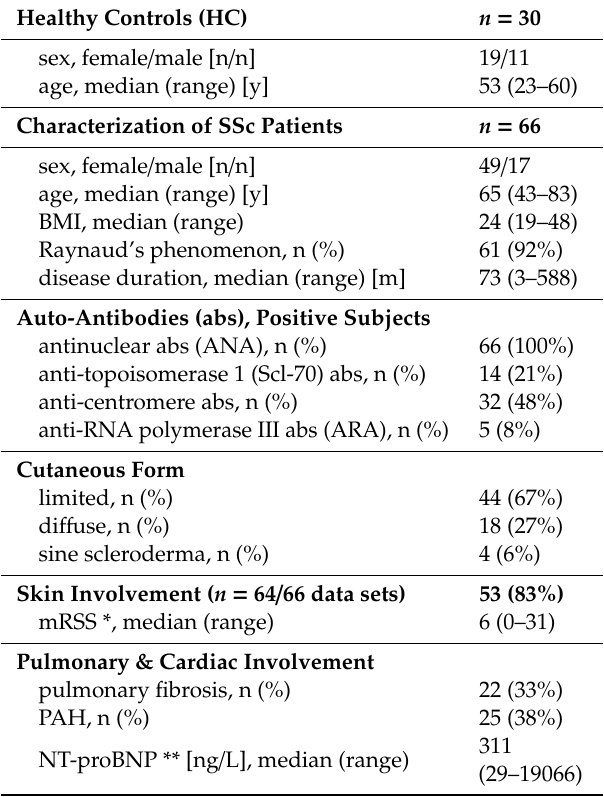
Table 1. Characterization of the study